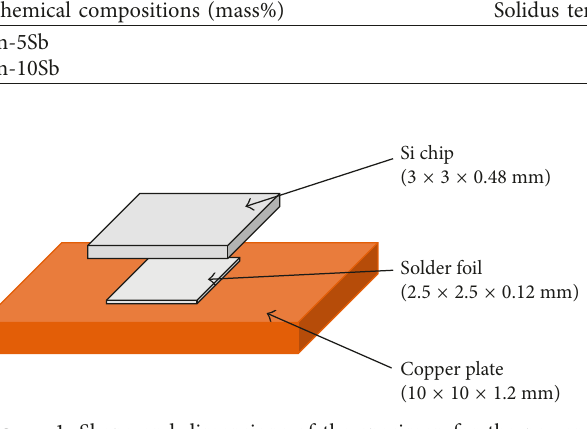
Figure 1: Shape and dimensions of the specimen for the power cycling test and heat aging test.